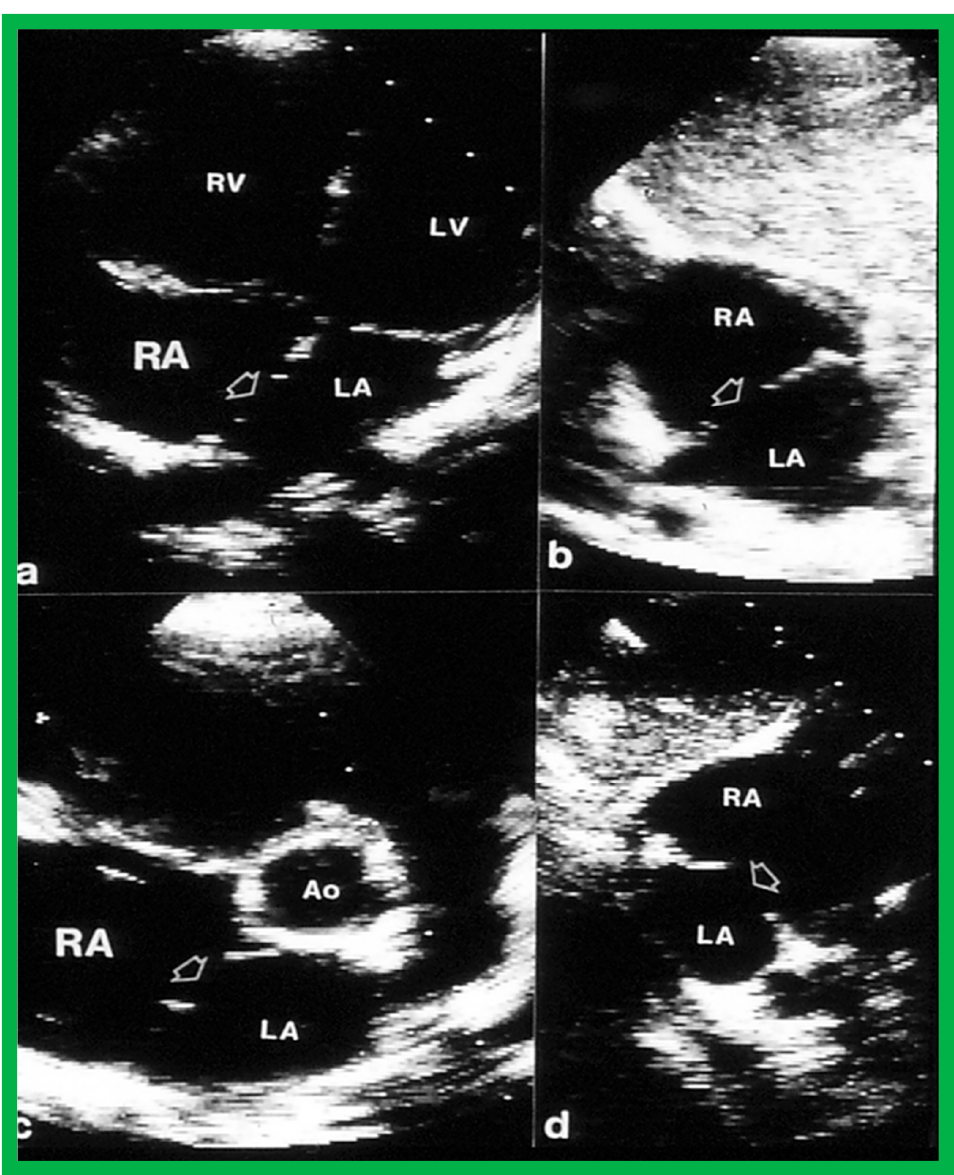
Figure 11. Two-dimensional transthoracic echocardiograms to illustrate the atrial septal rims in multiple views. The apical four-chamber ( a ), subcostal long-axis ( b ), parasternal short-axis ( c ), and subcostal short-axis ( d ) projections are shown. The unfilled arrowheads point to the ASD. Adequate-sized septal rims are seen in each image. This child is deemed to be a suitable candidate for percutaneous device occlusion. Ao, Aorta; LA, left atrium; LV, left ventricle; RA, right atrium; RV, right ventricle. Reproduced from Reference [25].